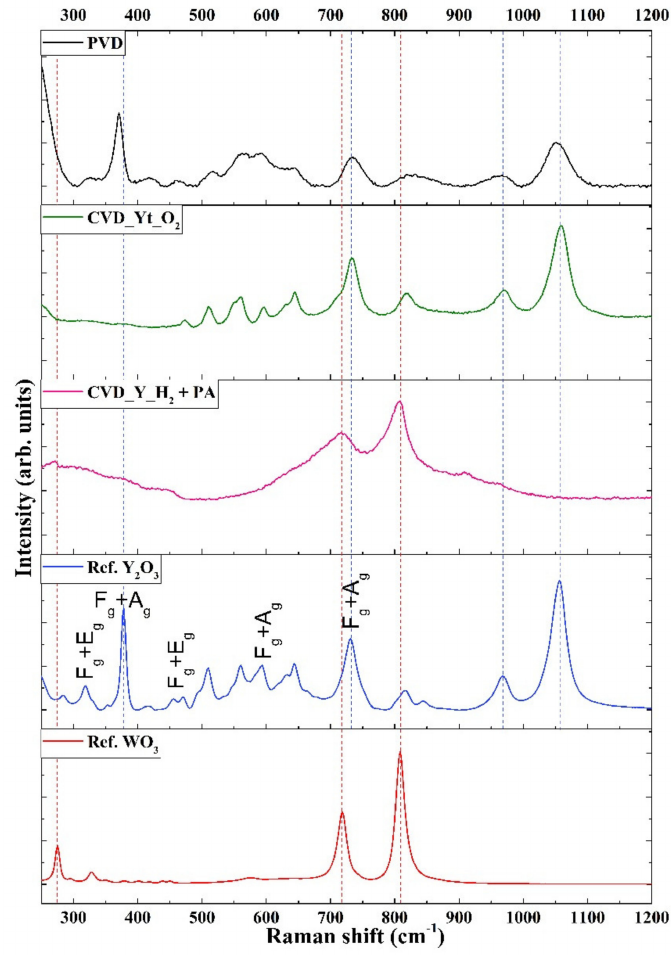
Figure 4. Raman spectra of CVD- and PVD-coated WO 3 /Y 2 O 3 /W f